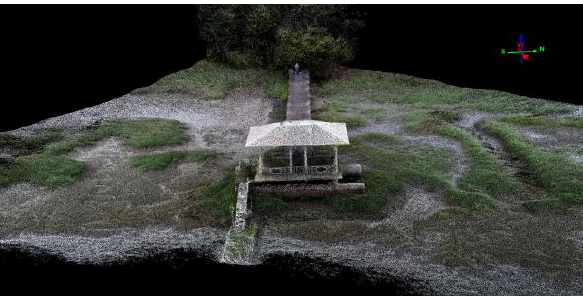
Figure 6. Point cloud from hand held photos of slave cabin.